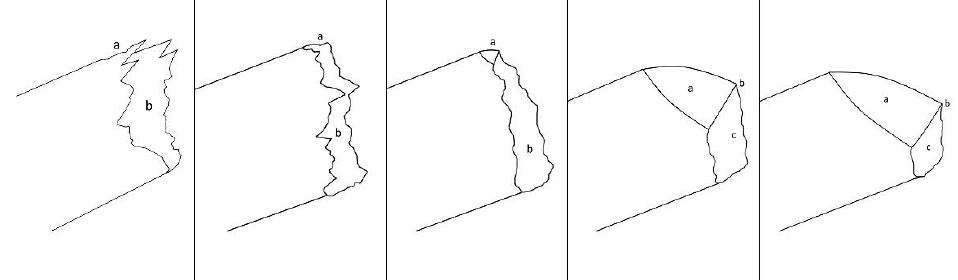
Figure 10. Schematic of Class 1 – 5 chop marks from left to right. Class 1 — (a) severe crushing (am- biguous point of impact) and (b) uncontrolled breakage. Class 2 — (a) moderate crushing and/or visible impact location and (b) uncontrolled breakage. Class 3 — (a) clear place of impact with lit- tle/no crushing and (b) controlled breakage. Class 4 — (a) small (<5 mm) sheared surface with lit- tle/no crushing, (b) kerf fracture, and (c) controlled breakage. Class 5 — (a) extensive (>10 mm) sheared surface with no crushing, (b) kerf fracture, and (c) controlled breakage